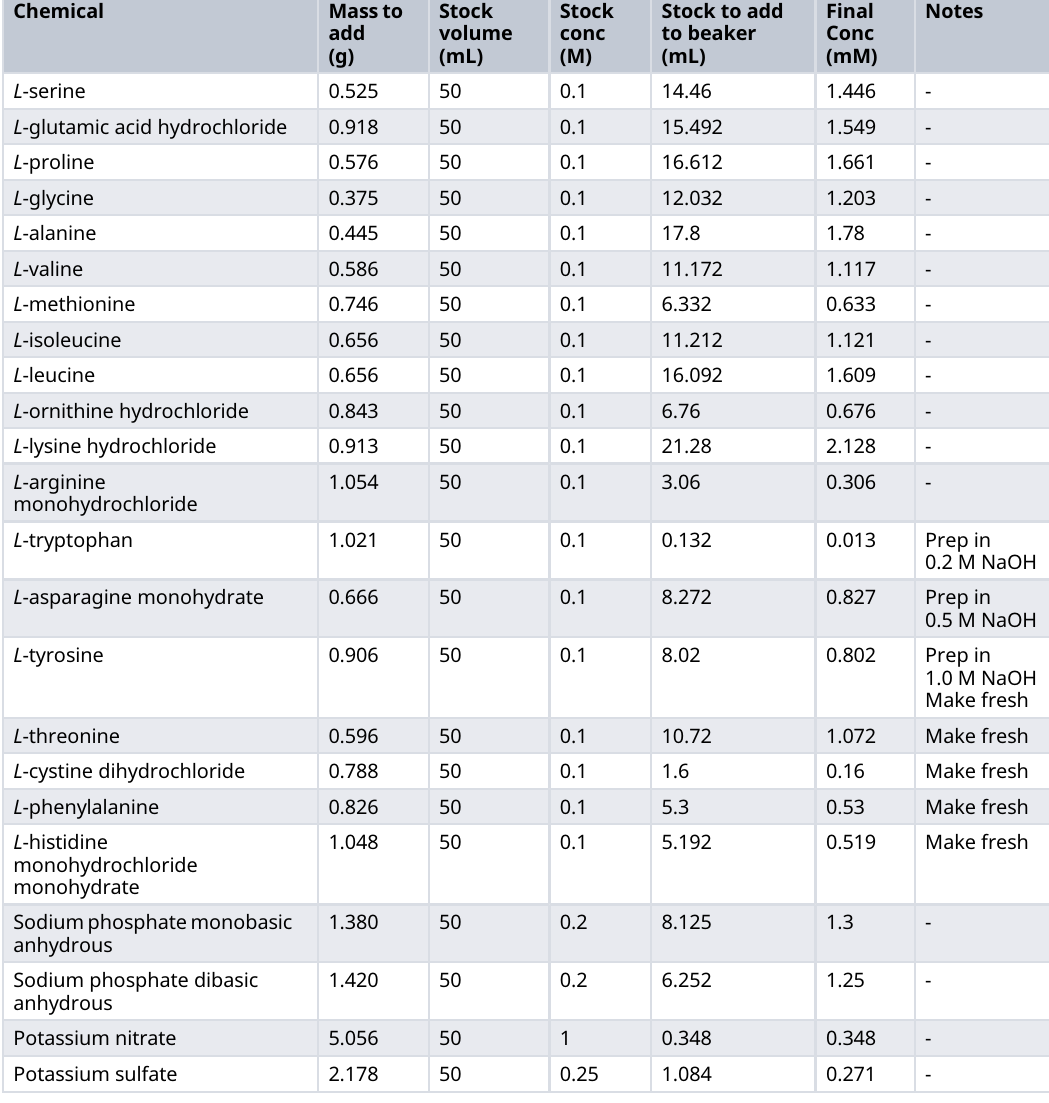
Table 4. Amino acid and salt stock solutions and volumes needed to make 1 L ASM. Chemical